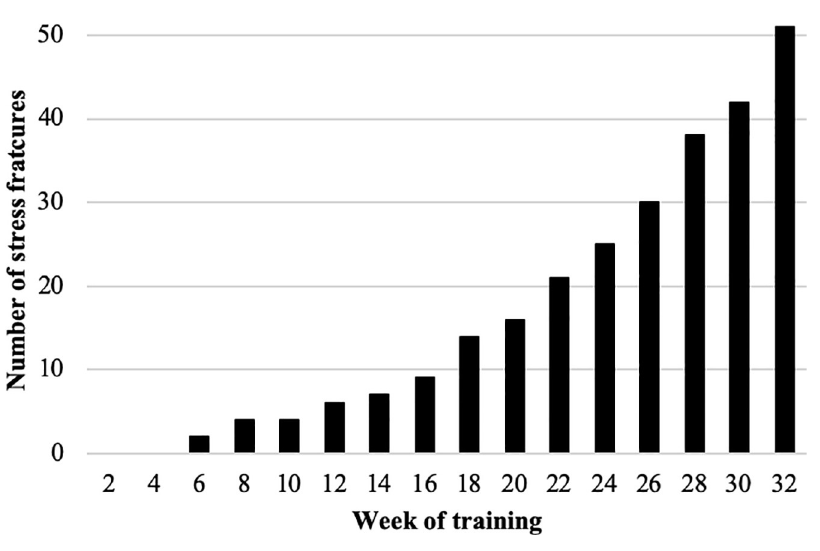
Fig 1. Cumulative stress fracture risk.